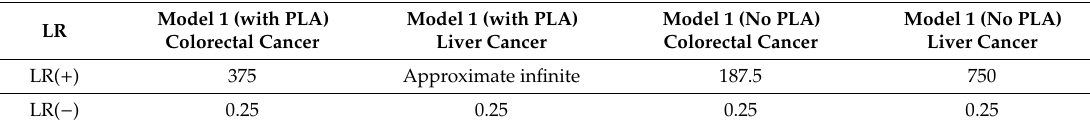
Table 12. Likelihood Ratios of the four models.